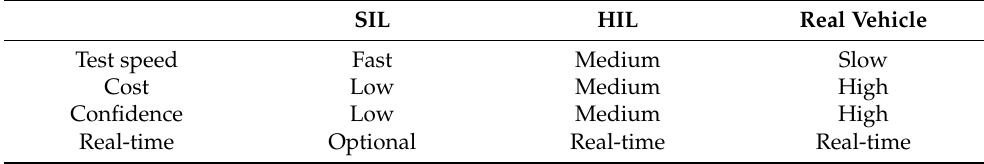
Table 1. Comparison of verification